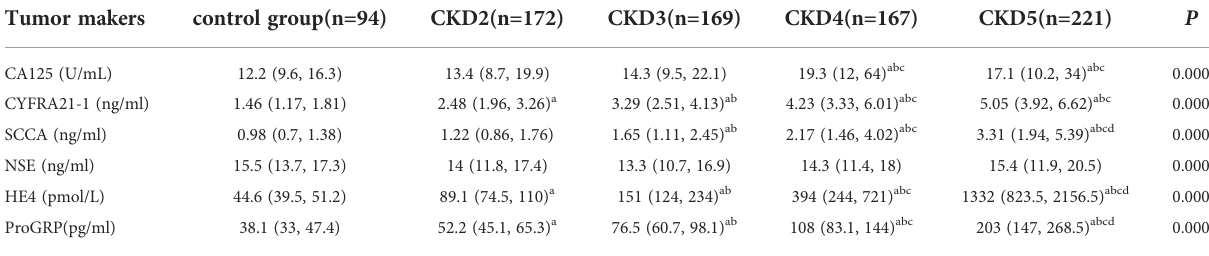
TABLE 3 Analysis of serum tumor marker levels in patients with different stages of CKD. Tumor